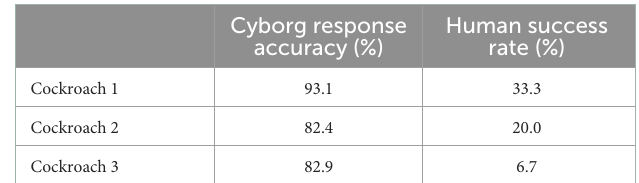
TABLE 1 Success in controlling cockroach